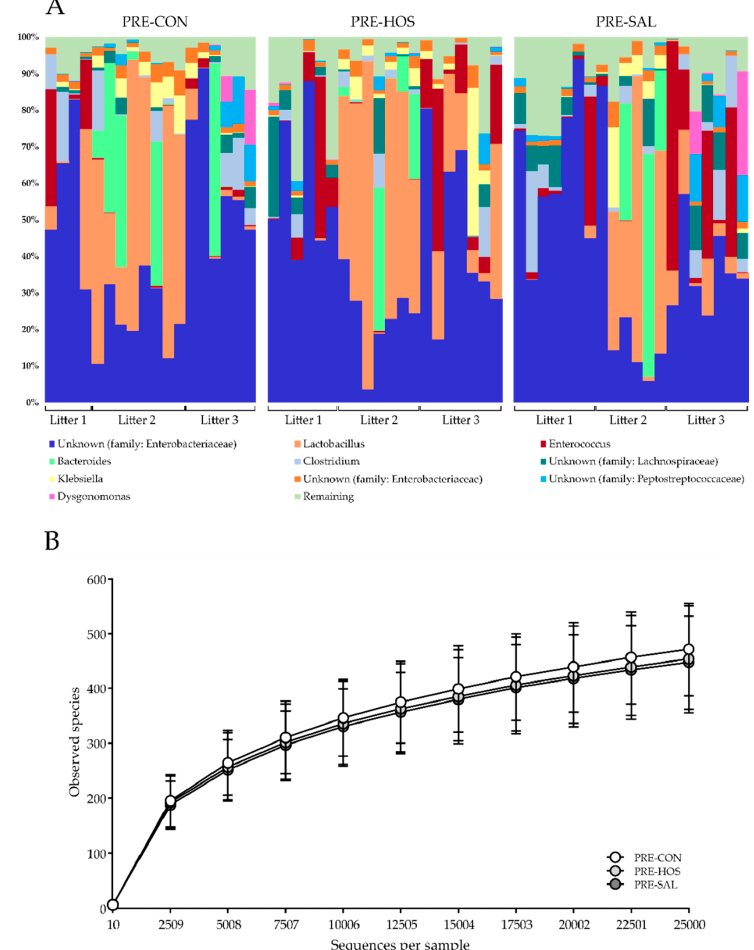
Figure 3. Microbiology in preterm pigs (Experiment 1). ( A ) Relative microbial abundance in colon for each preterm pig as determined by 16S rRNA gene amplicon sequencing. ( B ) Microbial diversity in colon of preterm pigs shown by the number of observed species. No differences were observed between PRE-CON (white) and the supplemented groups, PRE-HOS (light grey) and PRE-SAL (dark grey), respectively. Values are presented as mean ± SD.